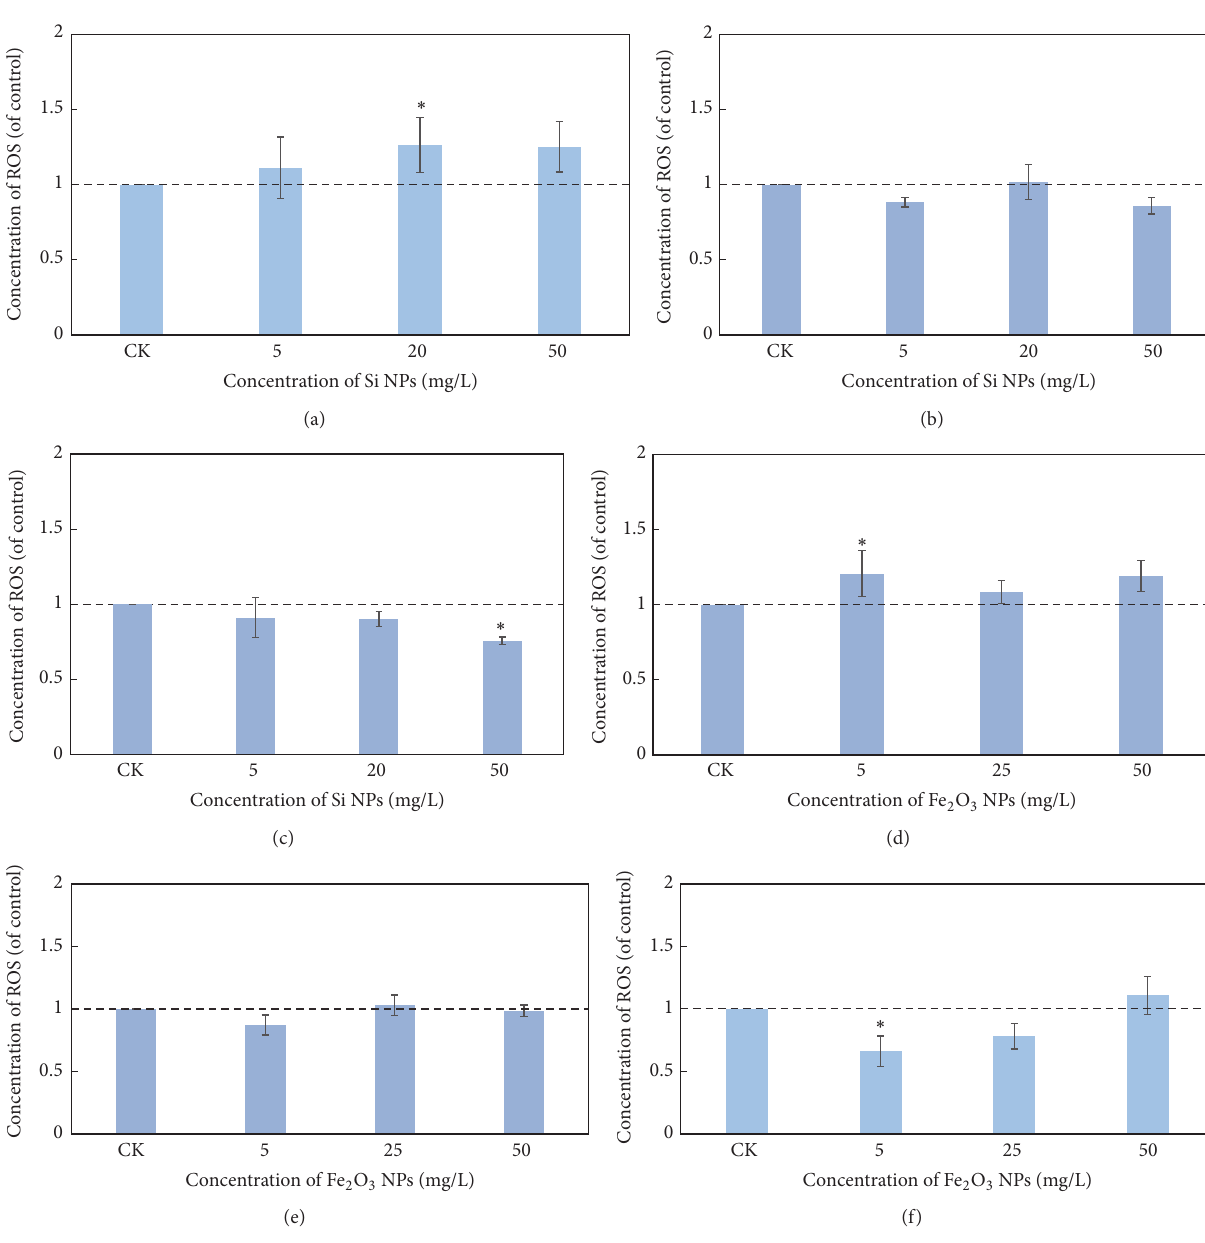
Figure 6: ROS concentrations at 2h in various reactor cycles in the presence of Si NPs (a, b, and c) or Fe 2 O 3 NPs (d, e, and f). (a, d) Cycle 1, (b, e) cycle 3, and (c, f) cycle 6. The error bars represent standard deviations from the mean. Asterisks indicate a statistically significant difference ( 𝑝 = 0.05 ) between the treatment and control